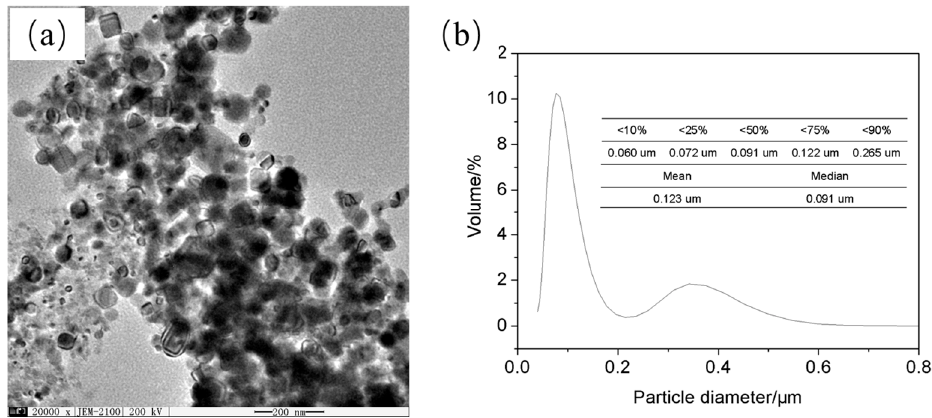
Figure 11. TEM image ( a ) and particle size distribution ( b ) of the product [96].